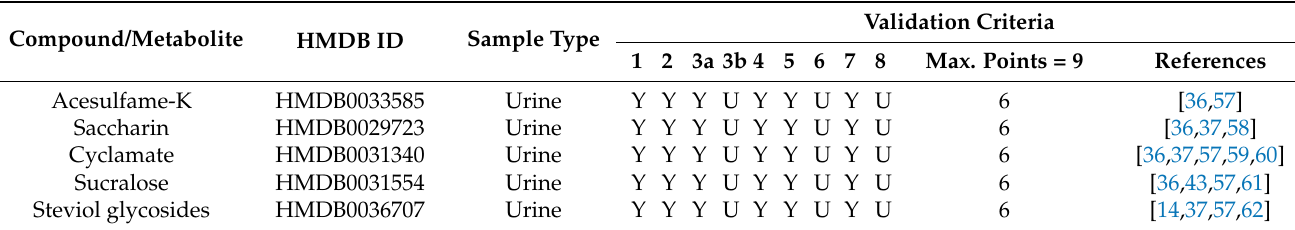
Table 3. Evaluation of the validity of the identified candidate biomarkers for the dietary intake of